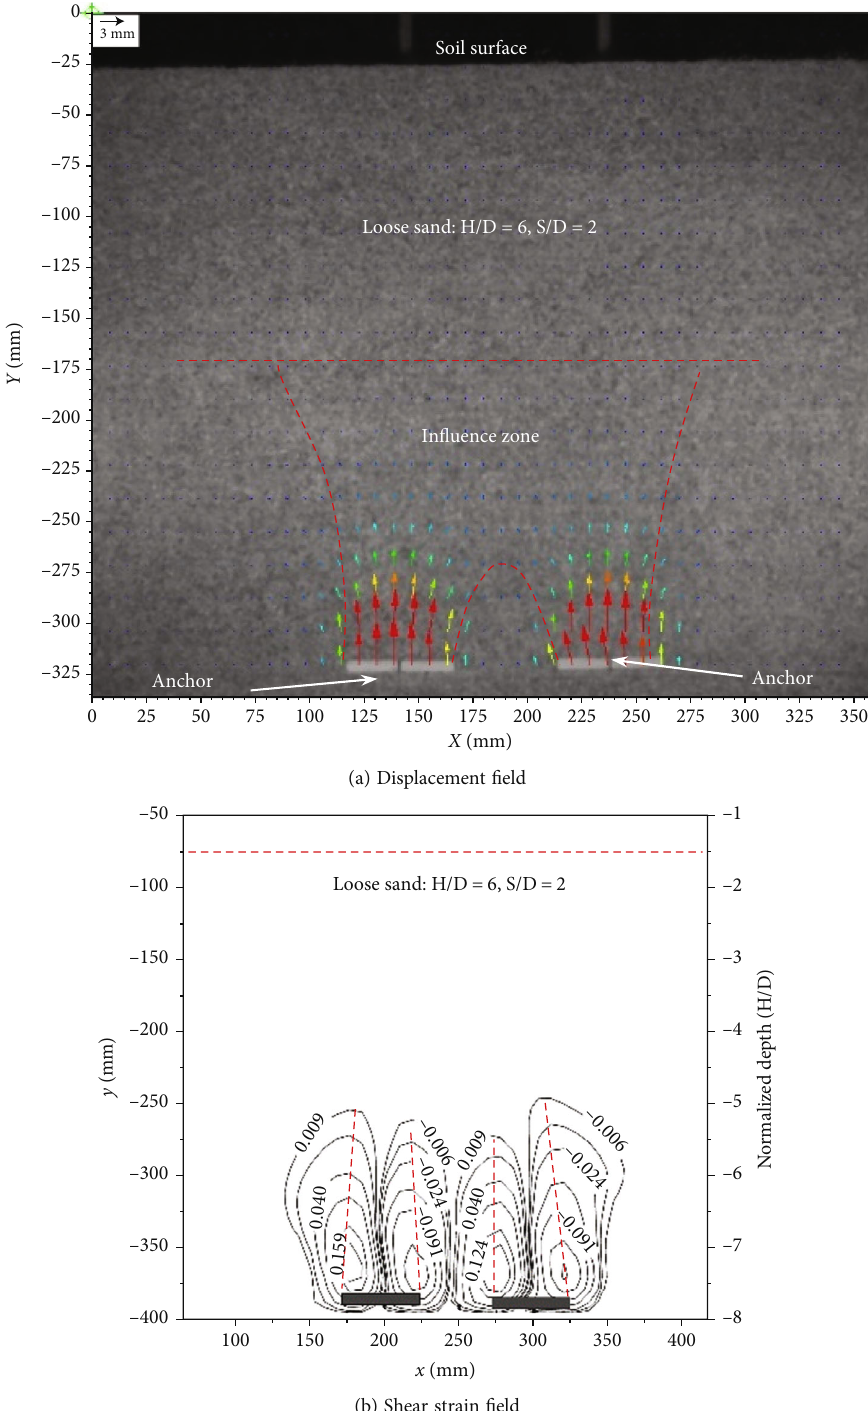
Figure 7: Soil displacement and shear strain fi elds for shallow group anchors in loose